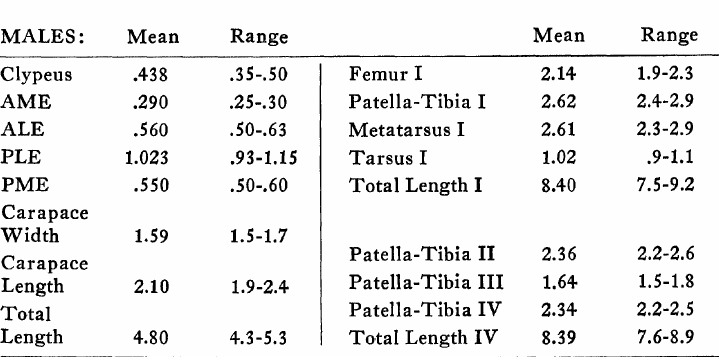
Color. Female. Face and chelicerae white with a. pair of wide dark brown stripes from _ALE to subdistal ends of chelicerae as illustrated in Figure I9. Carapace with median area white, bounded by wide dark brown submarginal stripes, with white at margins as in Figure 2o. Dorsum of abdomen with median white stripe outlined in black, becoming dark brown laterally. Two pairs of white marks posteri- orly as in Figure 2o. Venter with median area dusky, bounded by pale cream, becoming darker (light brown) laterally. Legs yellow to light brown, overlaid with dark hair. Femor,a with dark stripe along anterio-ventral surface. Labium and endites yellow. Sternum cream to pale yellow. Color. Male. Face with dark brown or black median area bounded by white and chelicerae with vertical black stripes as in Figure 67. Eye region black. Cymbia of palpi black. Carapace with broad median white stripe bounded by wide sub- marginal stripes, with the margins of the carapace white as in Fig- ure 68. Dorsum of abdomen with a median stripe bounded by black as in Figure 68. Venter with dark brown median stripe outlin’ed in pale cream to yellow and becoming darker laterally. Legs yellow to brown, overlaid with dusky hair, without distinct darker markings. Labium and endites pale yellow. Sternum cream to pale yellow. Diagnosis. Oxyopes cornutus, particularly the male, has a black and white color pattern simil.ar to O. tridens and O. pardus. The male of O. cornutus lacks a patellar apophysis such as that found